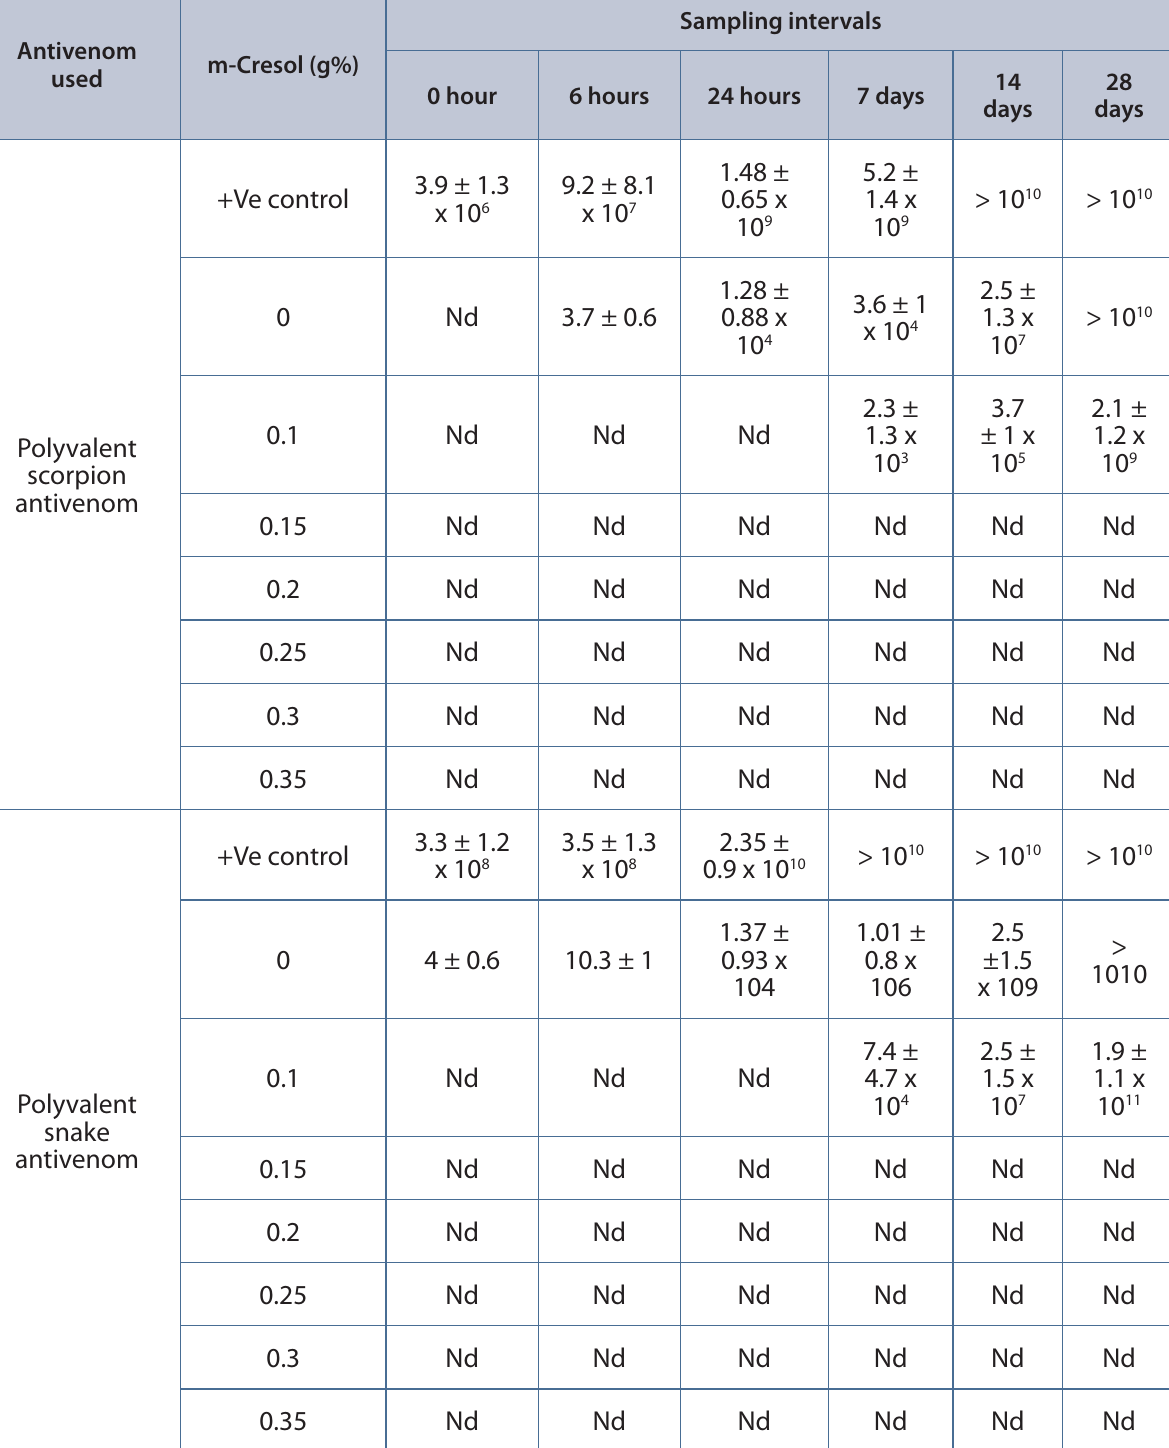
Values represent the mean of six samples followed by their respective standard error of the mean. CFU: colony-forming unit; Nd: not